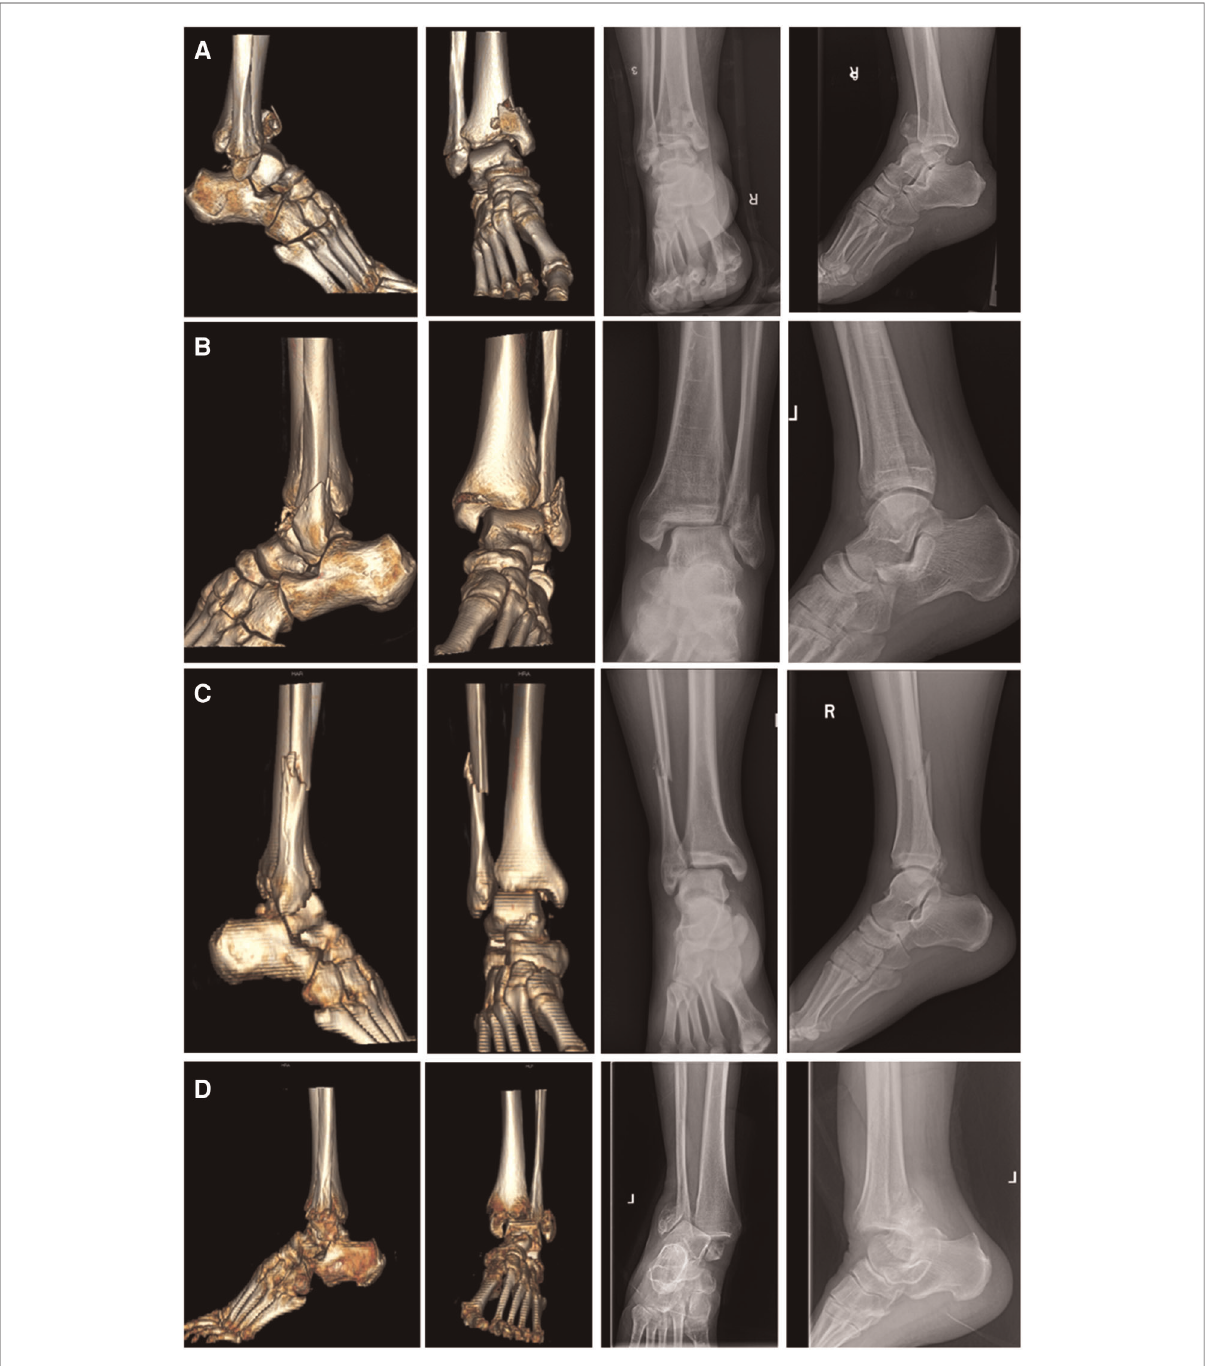
FIGURE 3 The CT reconstructions and radiographs of ankle fracture-dislocations with four different injury mechanisms according to the Lauge-Hansen ’ s classi fi cation. ( A ) Supination-adduction; ( B ) Supination-external rotation; ( C ) Pronation abduction; ( D ) Pronation-external